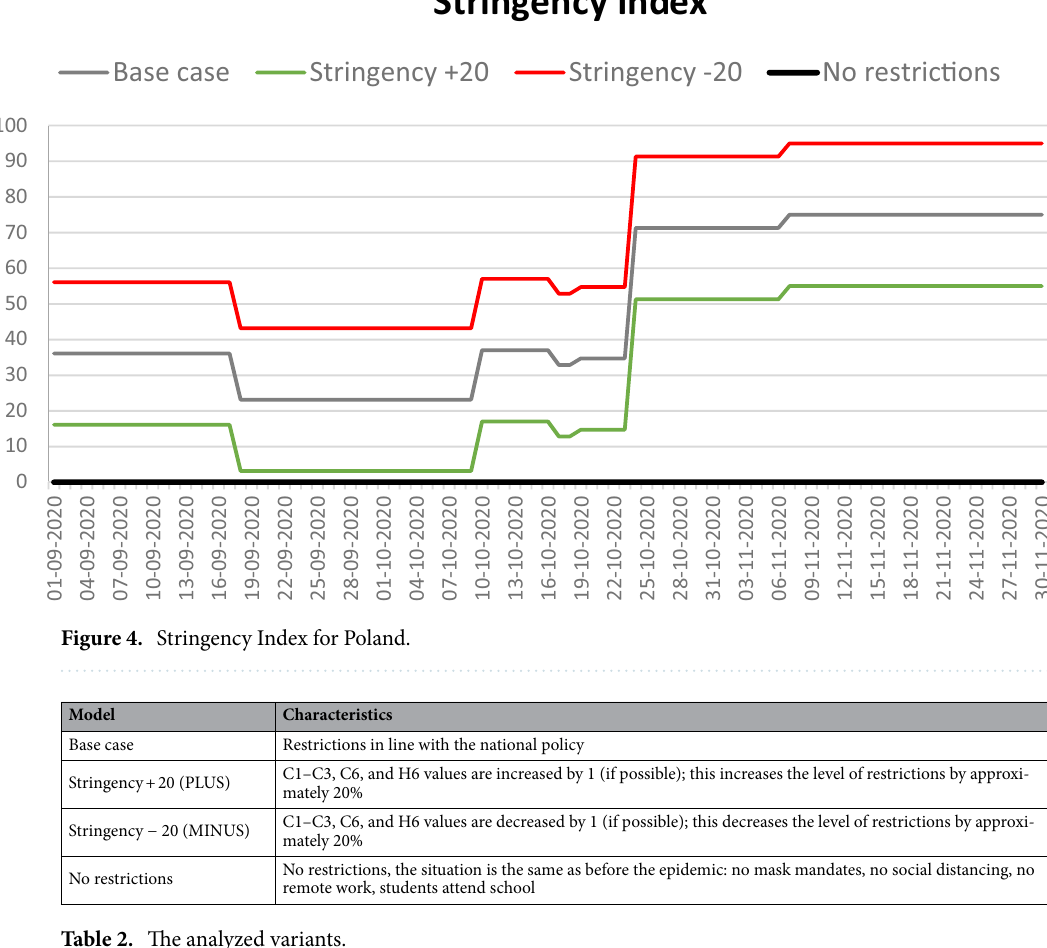
Table 2. The analyzed